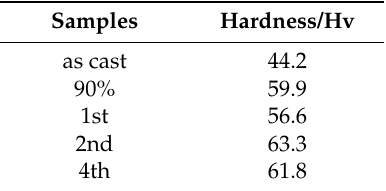
Table 1. The average hardness of Al-TiB 2 /TiC composites after rolling and different ARB cycles.